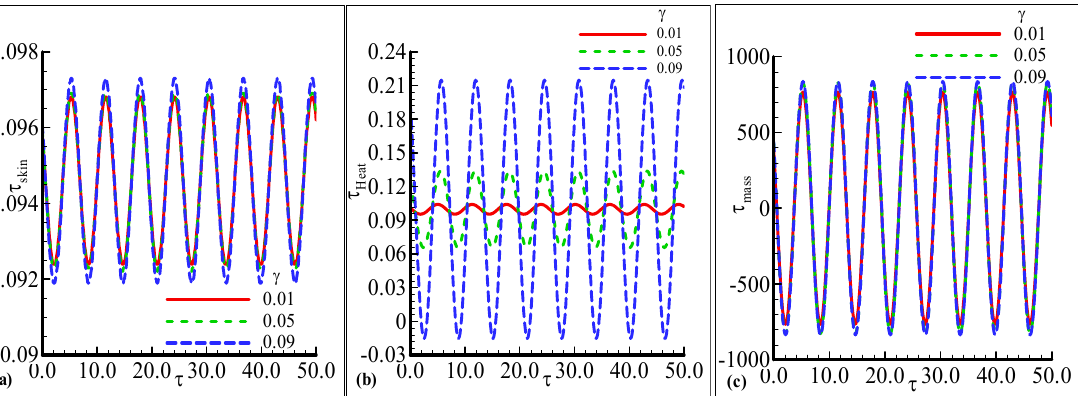
Figure 7. The physical profiles for τ skin , τ heat , and τ mass with choices of γ = 0.01, 0.05, and 0.09 and fixed Pr (cid:3404) 7.0 , 𝑆 (cid:3030) (cid:3404) 0.2 , 𝜆 (cid:3047) (cid:3404) 0.2 , 𝜆 (cid:3030) (cid:3404) 0.6𝐸 (cid:3404) 0.2 , 𝑛 (cid:3404) 0.3 , 𝜆 (cid:3404) 0.2 , 𝛽 (cid:3404) 0.2, and 𝜖 (cid:3404) 0.05 .